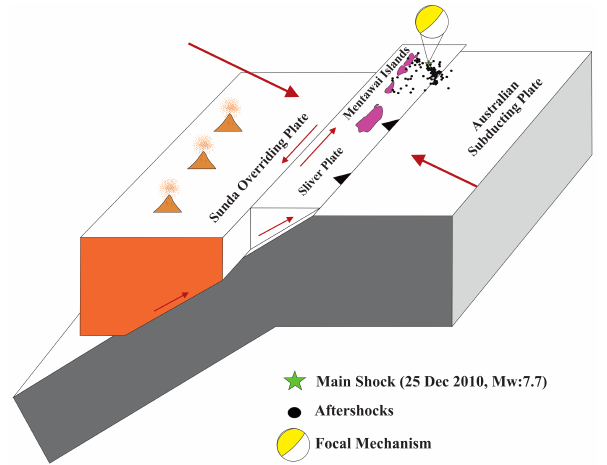
Fig. 8. The geometry of the overriding, sliver and subducting plates around the Mentawai Islands with the aftershock distiribution of the 25 October 2010 Kepulaunan Mentawai earthquake (Modified from McCaffrey, 2009).